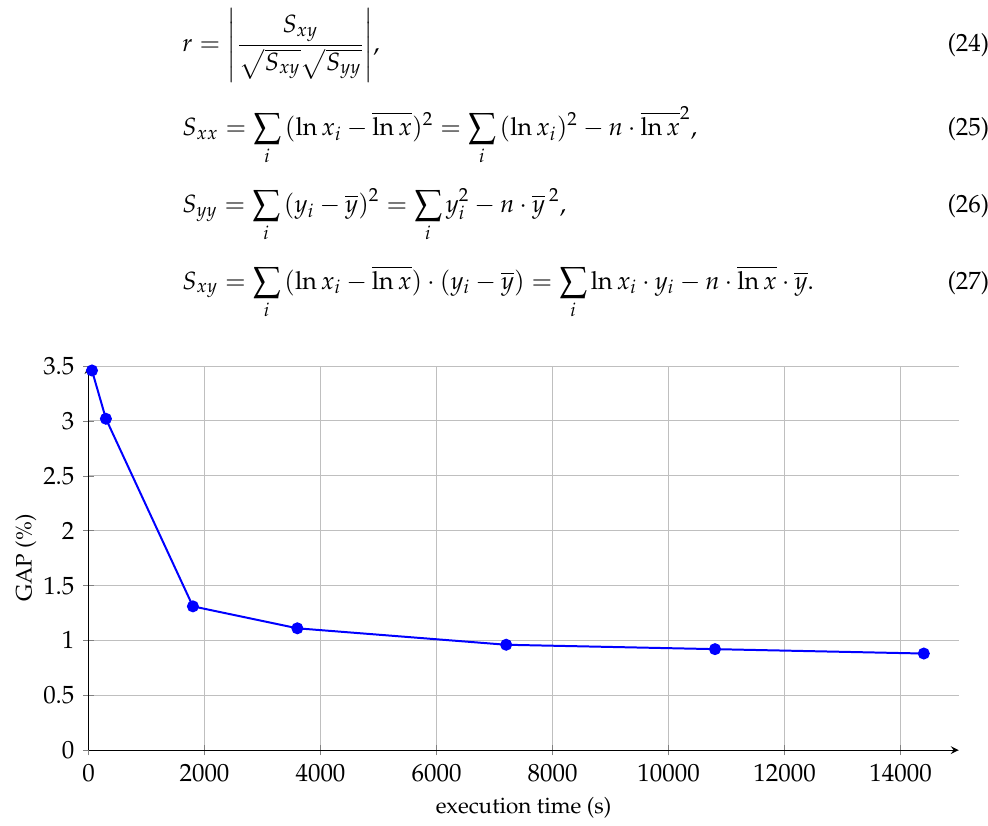
Figure 1. GAP evolution for the considered case